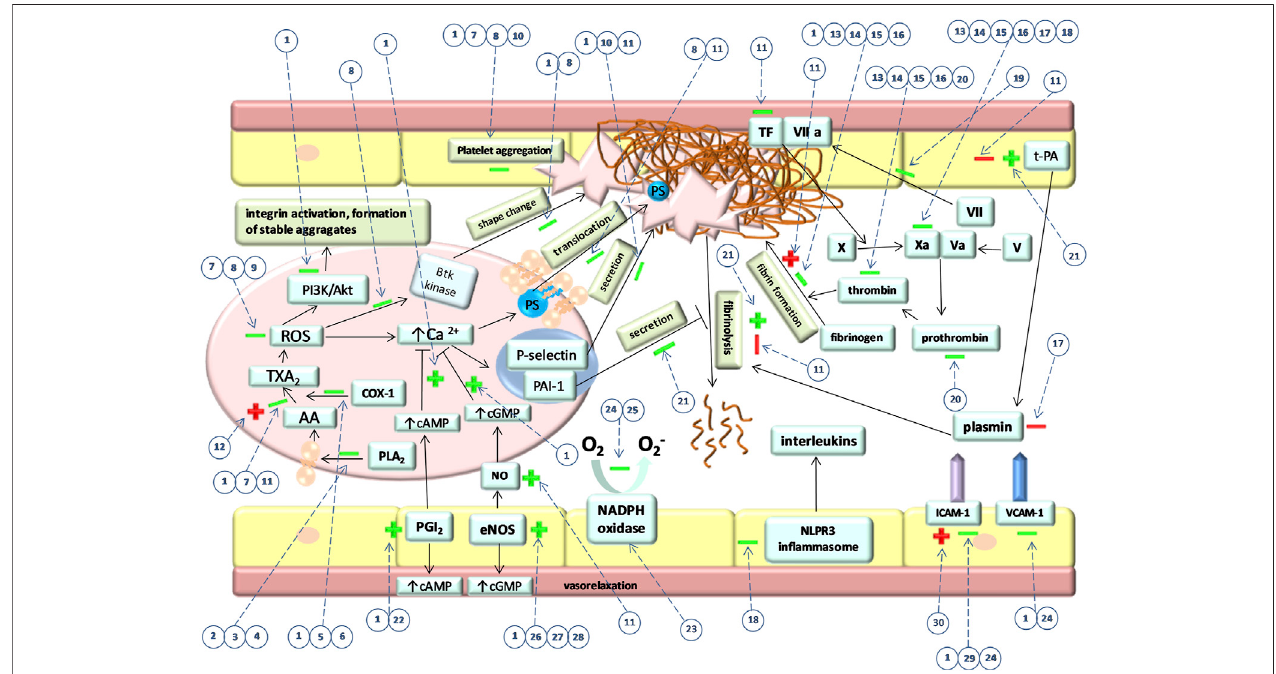
FIGURE2| Maineffectsoftanninsonhemostasis. “ → ” indicatesactivatorypathwaysand “ ˧ ” indicatesinhibitorypathwaysthatoccurduringhemostasisregulation. “ + ” and “–” indicate activatory and inhibitory effect of tannins on these pathways, respectively. Green color indicates favorable and red color indicates the unfavorable effect of tannins. Firstly, the picture shows the effect of tannins on particular signaling pathways in platelet which eventually also affect their shape change, PS translocation, secretion, and aggregation. Furthermore, the effect of tannins on coagulation factors and fi brin formation is shown. The in fl uence of tannins on fi brinolysis and components that regulate this process is presented. The picture shows also tannins effect on endothelial NO and PGI 2 synthesis as well as ICAM-1 and VCAM-1 expression. Numbers in circles represent speci fi c compounds, fractions or extracts. Dotted lines indicate the processes affected by tannins. (1) PGG, (2) parameritannin A1, (3) aesculitannin B1, (4) oligomeric B-type procyanidins, (5) O-trigalloyl-beta-D-glucose, (6) isocorilagin, (7) pomegranate extract, (8) cinnamtannin 1B, (9) water – methanolic procyanidin fraction of the water – methanolic extract obtained from Medemia argun nuts, (10) cocoa procyanidins, (11) water-methanolic Potentilla erecta rhizome extract, (12) rugosin E, (13) pedunculagin, (14) tellimagrandin II, (15) casuariin, (16) 5-desgalloylstachyurin, (17) procyanidin fraction of an aqueous extract of Brownea grandiceps Jacq., (18) procyanidin B2, (19) hamamelitannin, (20) walnuts, (21) corilagin, (22) procyanidin-rich chocolate, (23) procyanidin fractions from grape pomace, (24) grape seeds procyanidin, (25) procyanidin fraction of a water – ethanolic extract from Croton celtidifoliu s, (26) 2,3-cis procyanidins (isolatedfromtheethylacetatefractionofamethanolicextractfrom Neliameyeri leaves(27)2,3-transprocyanidins(isolatedfromtheethylacetatefractionofamethanolic extract from Salix spp. Bark, (28) procyanidin C1 (29) procyanidin fraction of an acetone – water extract obtained from Ribes nigrum , (30) polyphenol fractions of acetone – water extracts obtained from Rubus caesius and Rubus idaeus